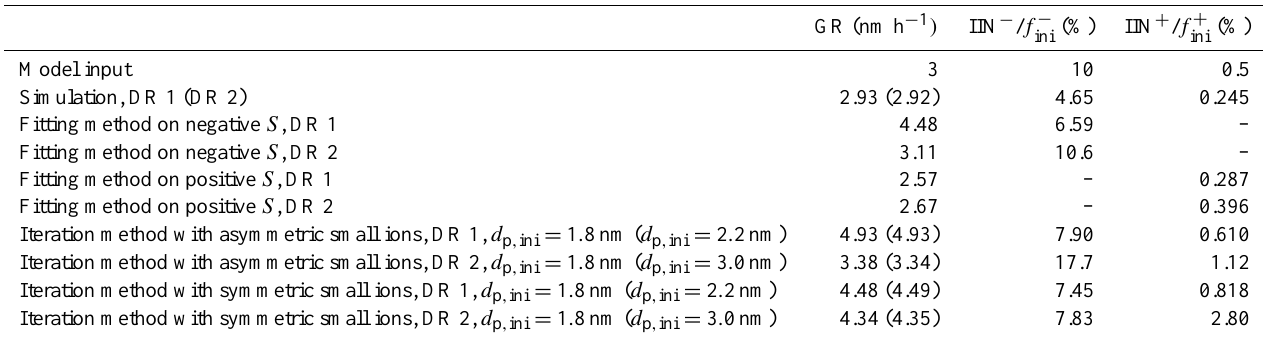
Table 3. The values related to the example simulation described in Sect. 4.2. The starting diameter used when solving Eqs. (5) and (6) is denoted as d p , ini . DR 1 and DR 2 denote the diameter ranges 1 (2.2–11.5nm) and 2 (3–11.5nm),